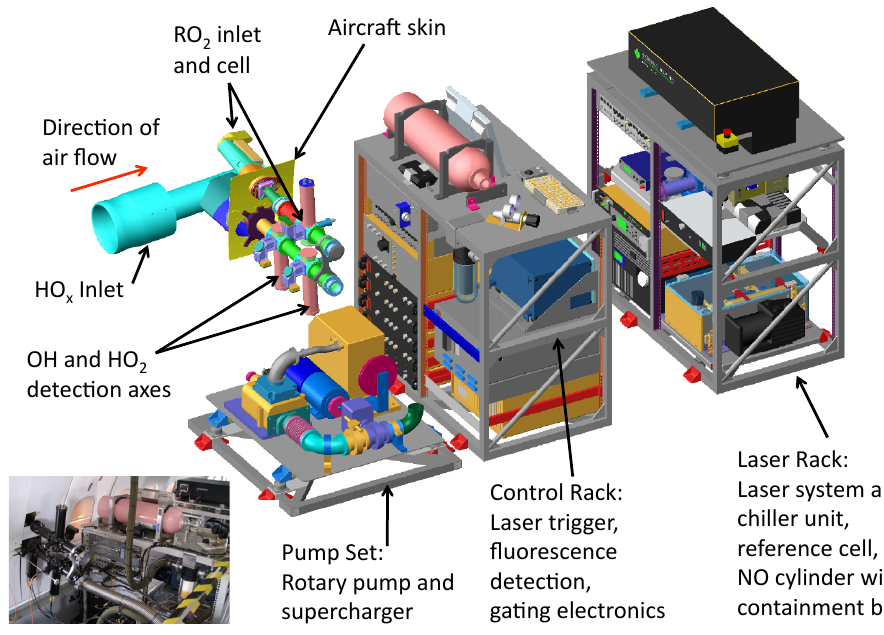
Fig. 1. Schematic outline of the Leeds aircraft FAGE instrument. Individual components are detailed in the text. The inlet delivers air to the fluorescence cell with OH and HO 2 detection axes. The cell is maintained at low pressure (1.5–2.1Torr) by a rotary pump backed by a supercharger (Pump Set). The fluorescence cell and pump set are not joined for clarity. The Control Rack contains the instrument computer with photon counting cards, the photomultiplier power supplies and gating electronics, the laser trigger module and a nitrogen cylinder. The Laser Rack holds the YAG pumped Ti:Sapphire laser and chiller unit, the reference cell and a B2 size NO cylinder for HO 2 measurements. The NO cylinder is housed in a containment box designed to prevent any NO leak in the aircraft cabin in case of failure of the cylinder or regulator. Fibre optic cables (not shown) deliver the laser light from the laser to the OH, HO 2 and reference cells. An inlet and fluorescence cell for the detection of RO 2 have been fitted but are not yet